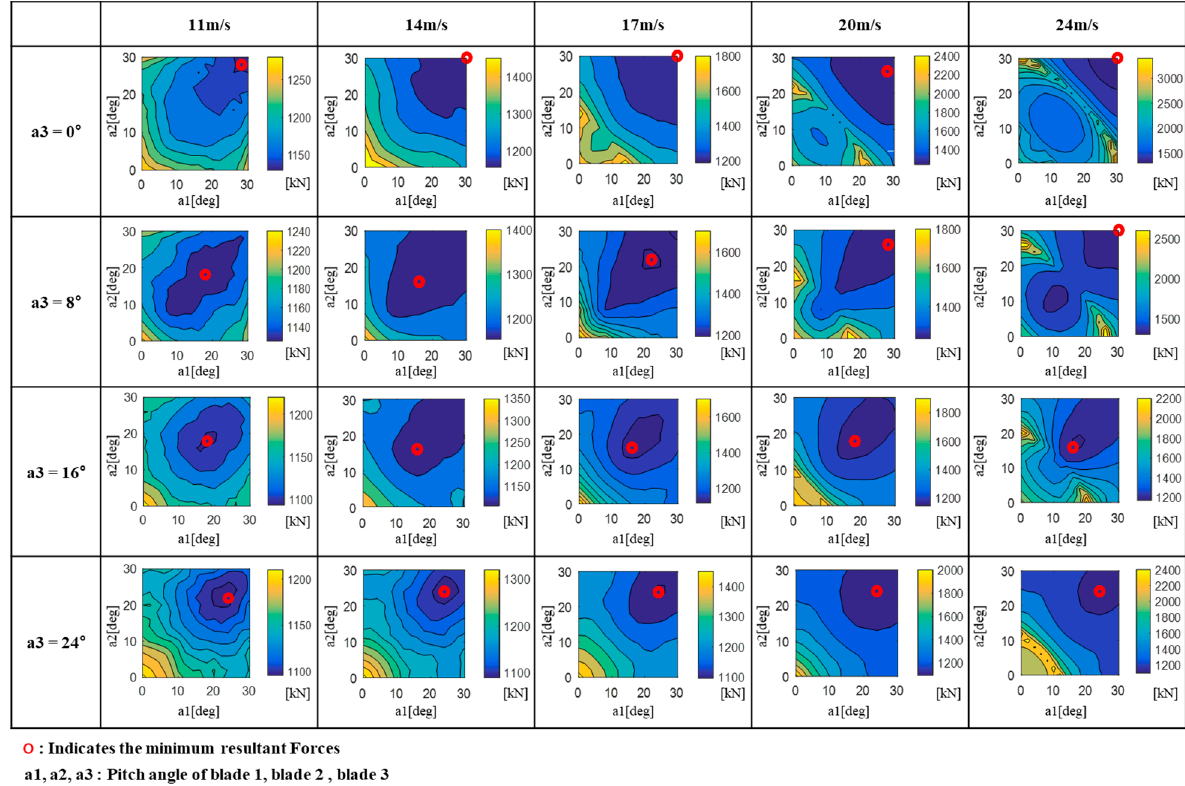
Figure 6. Aerodynamic imbalance loads of F R_ipa .